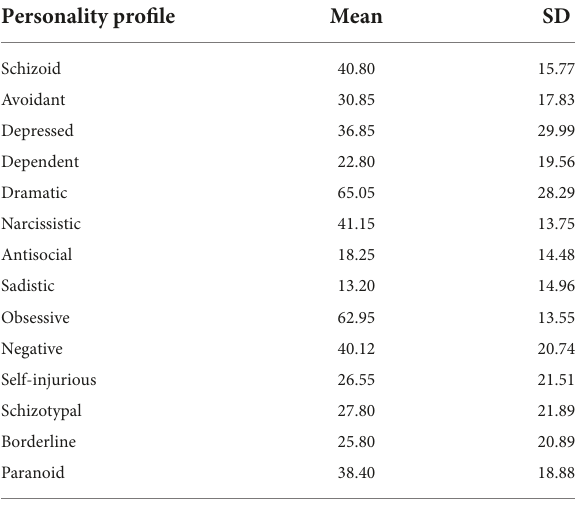
TABLE 2 Mean and standard deviation of personality profile scores in patients with type 2 diabetes.